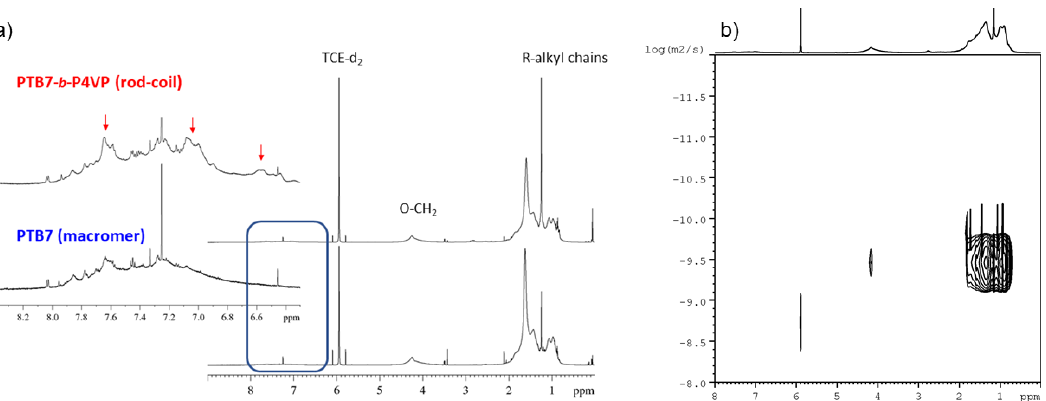
Figure 1. ( a ) 1 H ‐ NMR spectra of the macromer PTB7 (down) and of the rod–coil PTB7 ‐ b ‐ P4VP (up). The red arrows indicate the most relevant differences in the aromatic region between the two samples. The narrow and well ‐ defined peak at 7.26 ppm is due to chloroform residual in the analyzed sample, not coming from deuterated solvent. ( b ) Diffusion ordered spectroscopy (DOSY) spectrum of the PTB7 ‐ b ‐ P4VP (the diffusion coefficient (in m 2 /s) is plotted in a logarithmic scale against the chemical shift in δ .